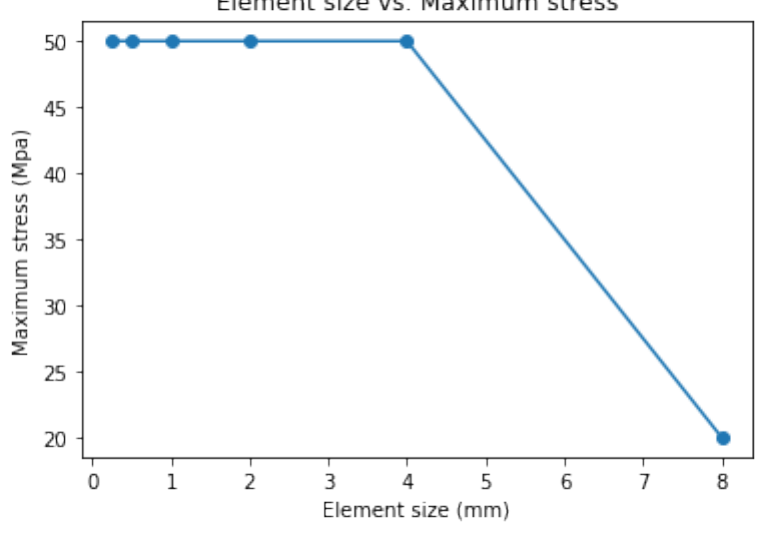
Figure 23. Element size vs. maximum